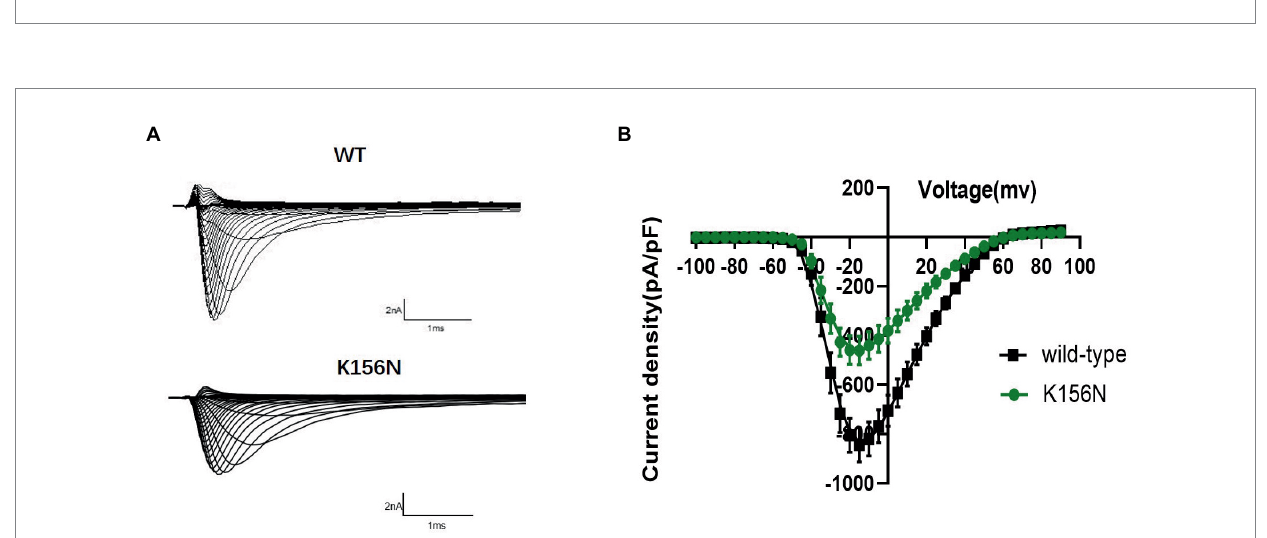
FIGURE 4 (A) Representative current recordings from WT and K156N Na v 1.2 obtained using the voltage protocol shown in Figure 5B. (B) Current density for Na v 1.2 wild-type( n = 15) and K156N variant( n =